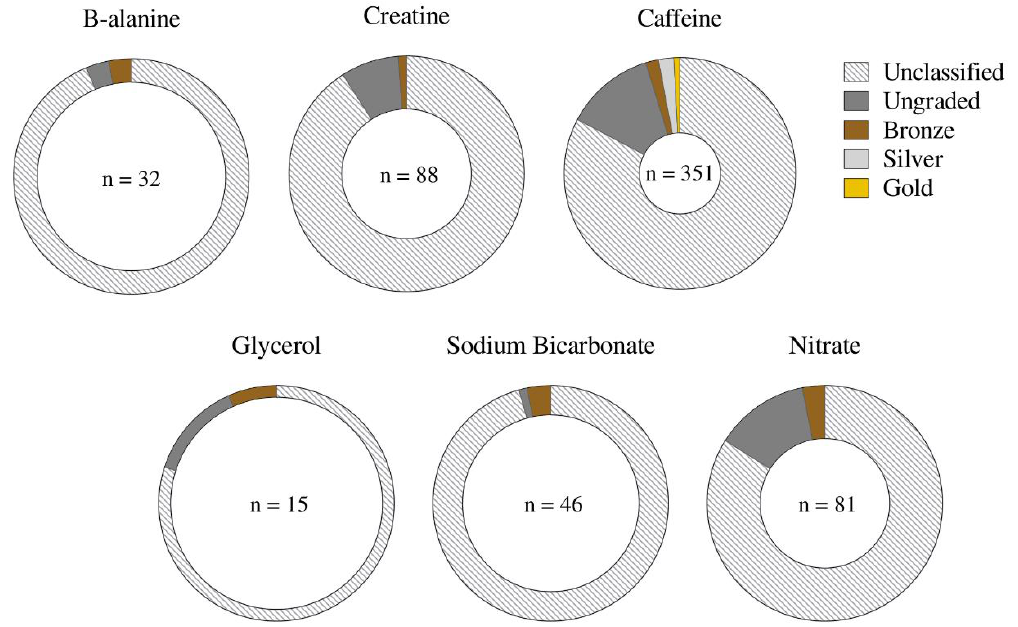
Figure 5. Proportion of studies classified into each tier [1], reflecting the standard of methodological control regarding ovarian hormonal profiles, as a proportion of the total number of studies including women across each supplement. Gold standard (best practice methodologies, as outlined by Elliott-Sale et al. [27]), silver/bronze (achieve some, but not all, methodological considerations), ungraded (menstrual status is defined, but methodological control is insufficient to award bronze/silver/gold) or unclassified (insufficient information to provide a robust classification of participants, or a mixed female cohort in which individual menstrual status cannot be discerned).